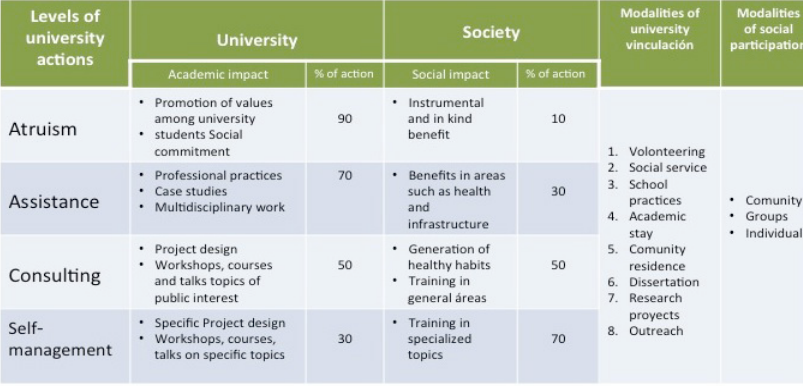
Figure 3. Definitions of impacts, action percentages and reduction of dependence (as action by society increases, dependence